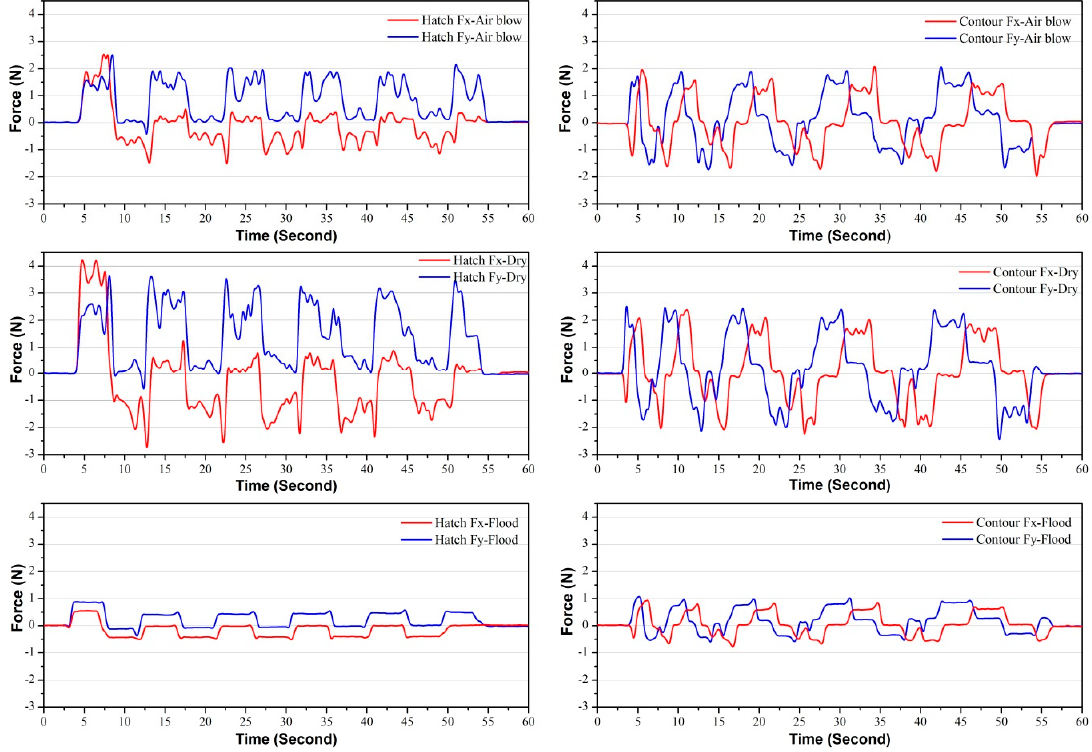
Figure 4. The effect of cutter path strategies and the coolant factor on cutting force.